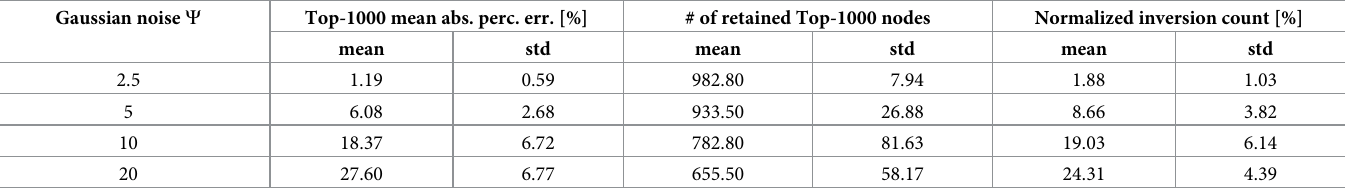
Table 4. Sensitivity of W2C-Fast-BC to different levels of random noise introduced on G 08:00 . Gaussian noise C Top-1000 mean abs. perc. err. [%]